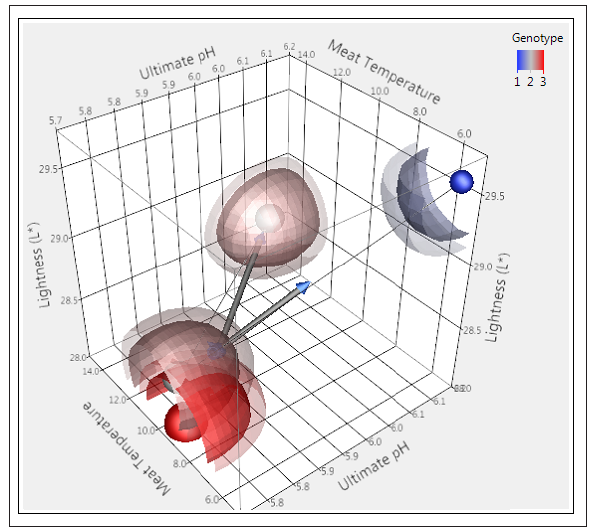
The first three principal components of beef Muscularis longis- simus thoracis et lumborum muscle from heifers for meat attri- butes related to meat quality.